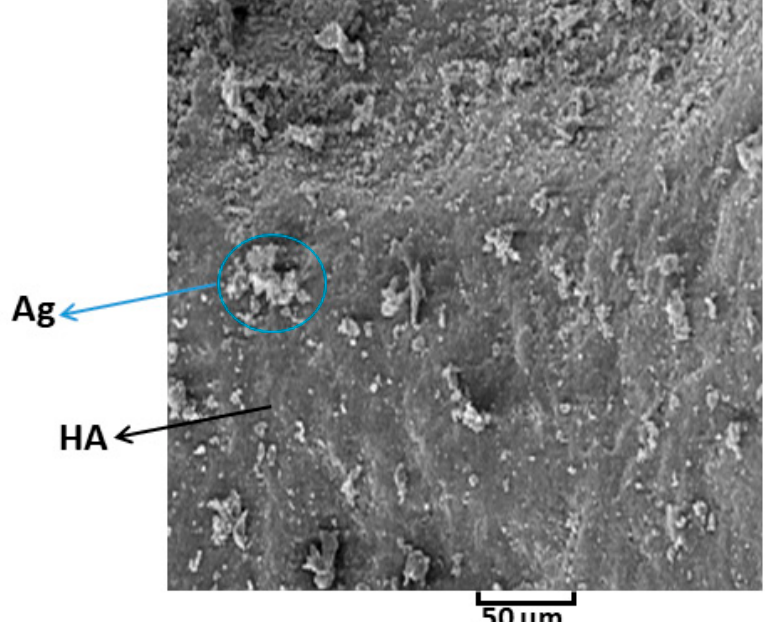
Figure 9. SEM image of Ag-doped HA powder.